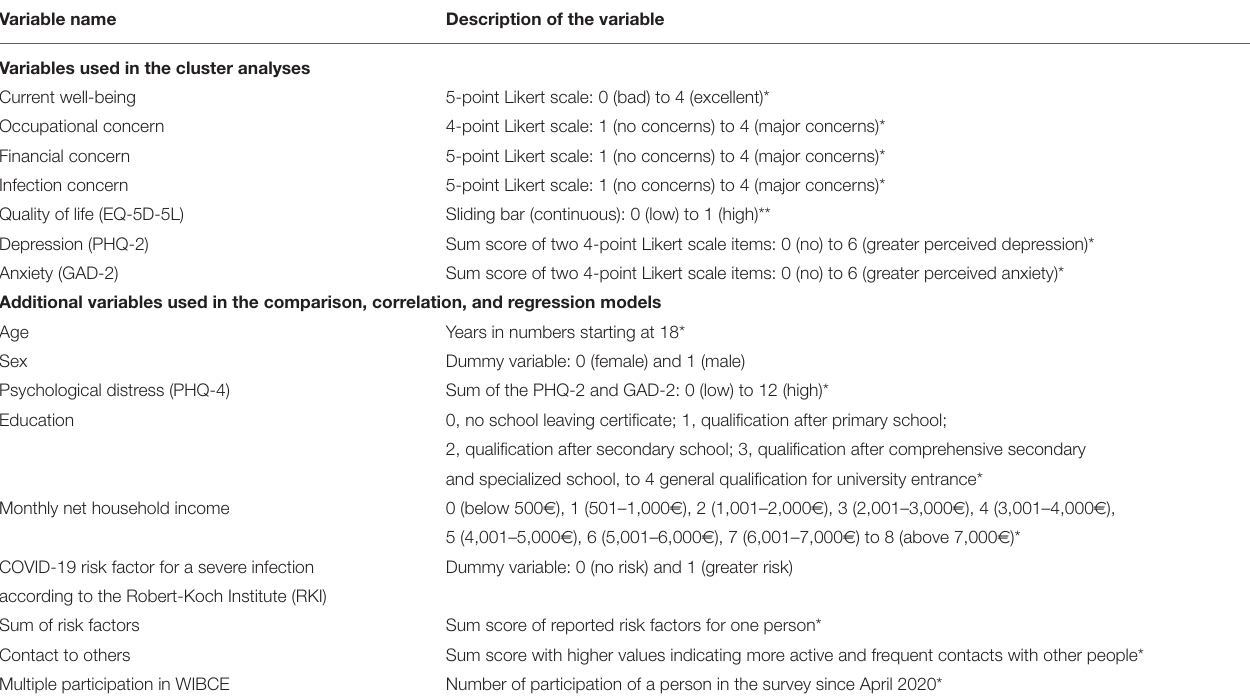
TABLE 1 | Overview of the variables of the online survey